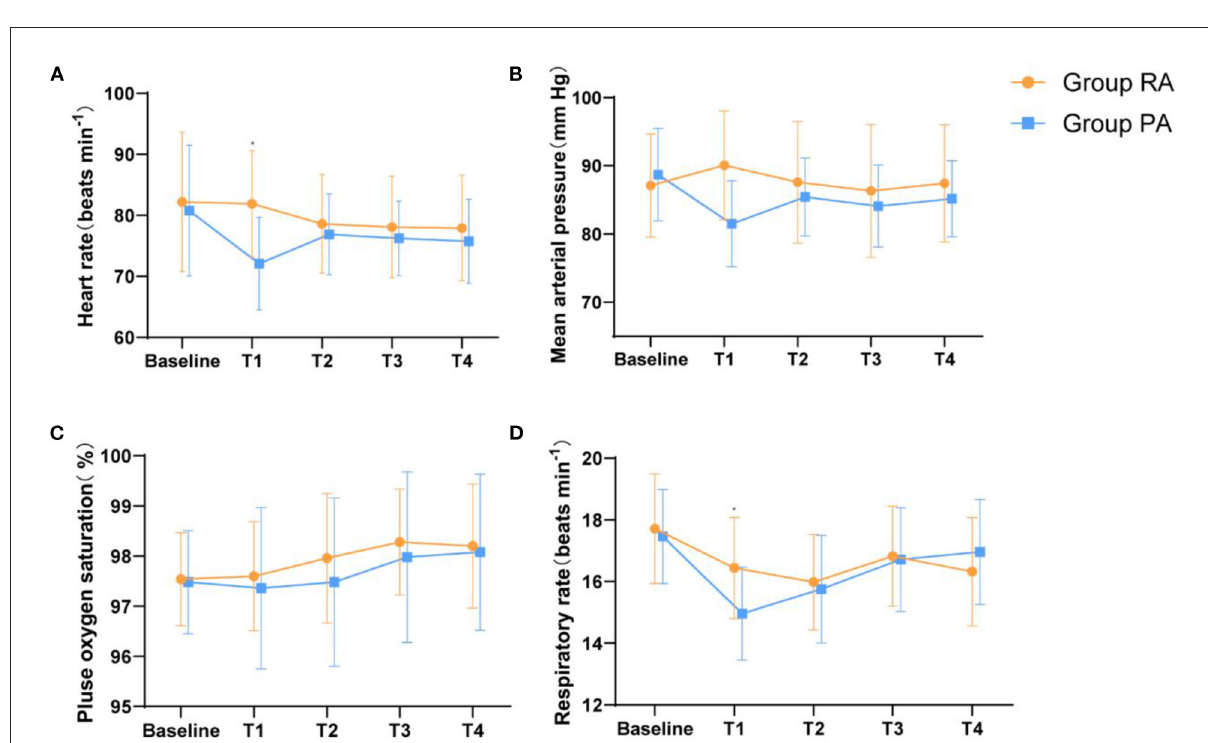
FIGURE3 Haemodynamic and respiratory parameters changes during the moderate sedation. (A) HR, (B) MAP, (C) RR, and (D) SpO 2 .Baseline, before administration of remimazolam/propofol; T1, at the start of the local anesthesia; T2, at the start of the operation; T3, 15min after the start of the operation; T4, end of the operation. Data are expressed as mean (SD). * P < 0.05 compared with Group